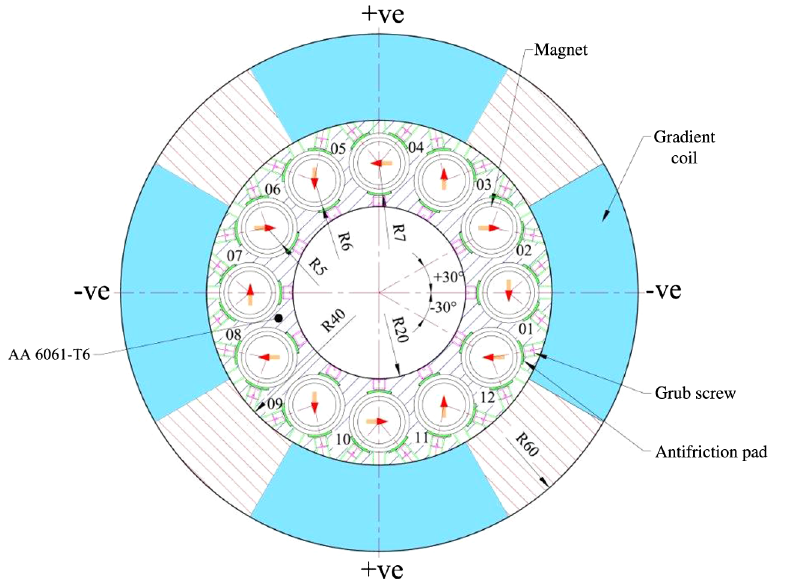
FIG. 2. Schematic view of the base mechanical structure to accommodate 12 cylindrical-shaped permanent magnets and the position of the current-carrying conductors needed for field tuning.